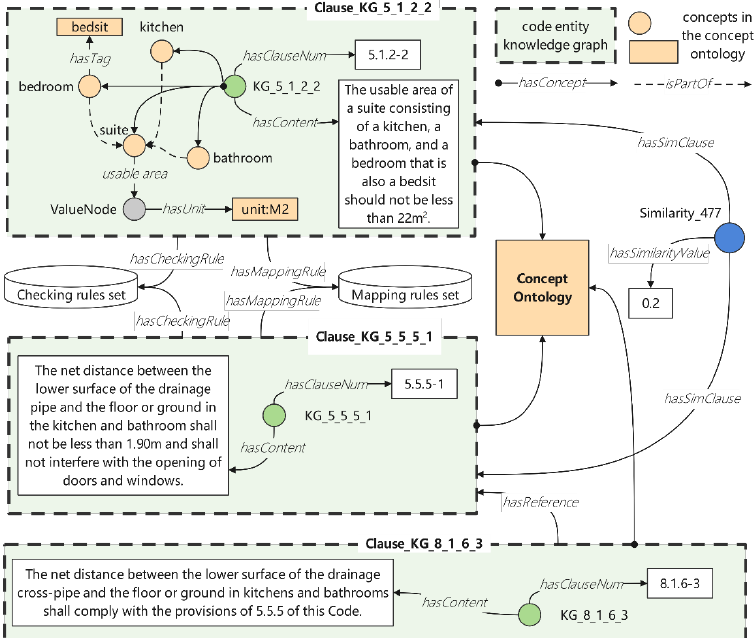
Figure 17. Part of the multiscale knowledge model for residential building design codes.